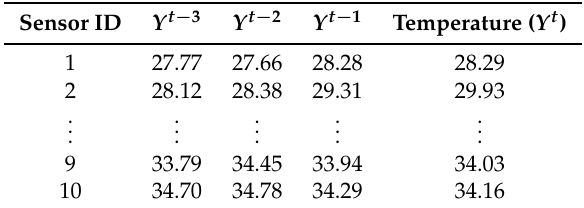
Table 2. The form of training data for temporal model at timestamp t